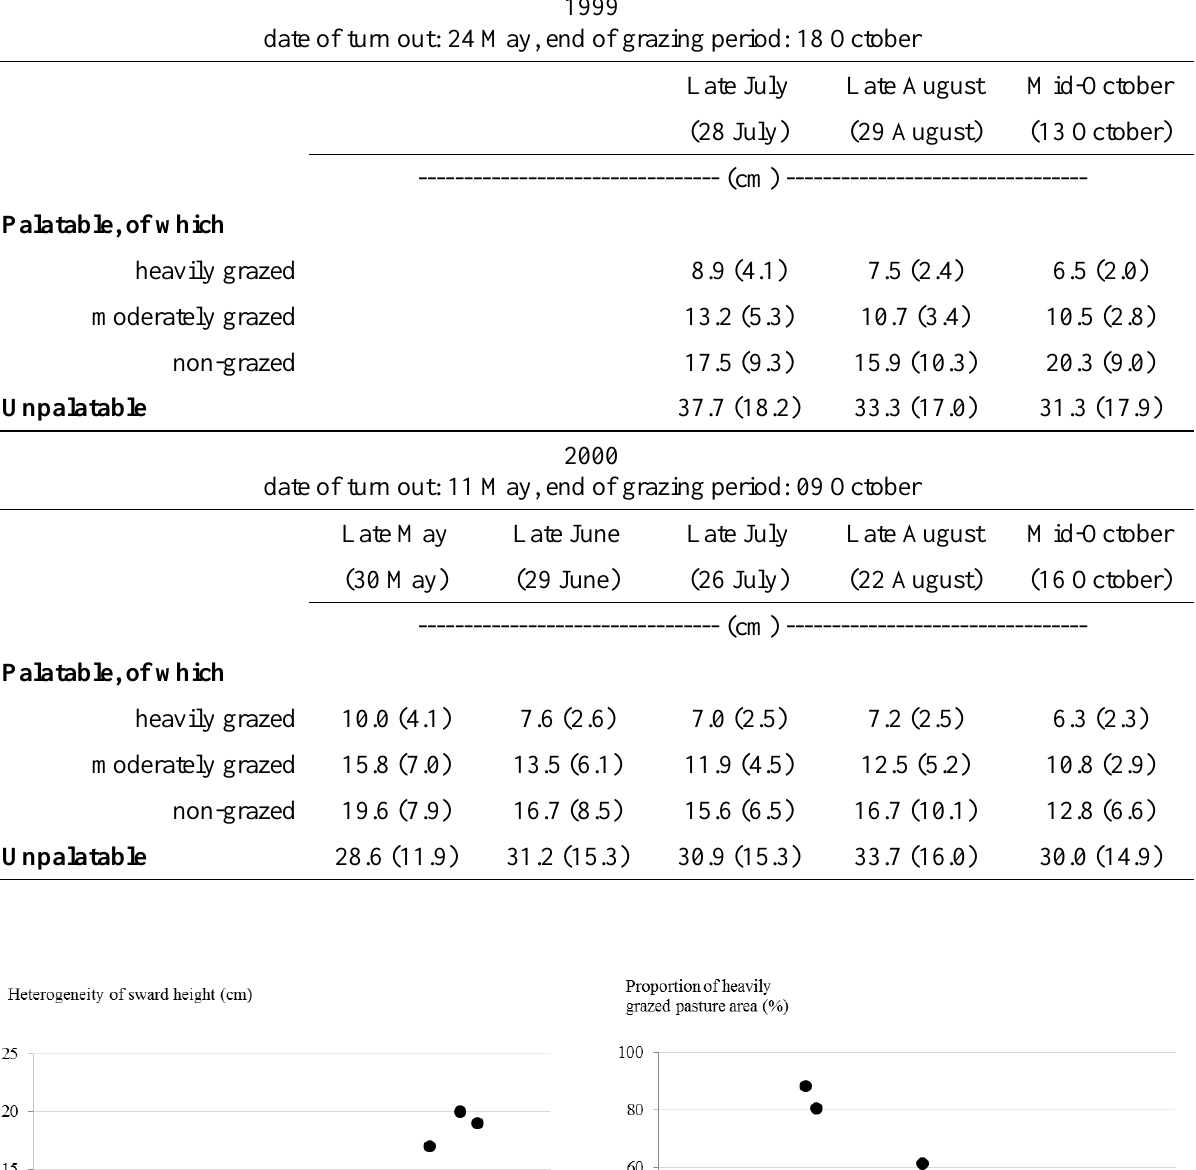
Table 2. Compressed sward height (cm) (in brackets: standard deviation) in pasture areas with palatable vegetation grazed by cattle at differing intensity and in areas with unpalatable vegetation during the grazing periods or shortly after the end of grazing, for the two years of the study.